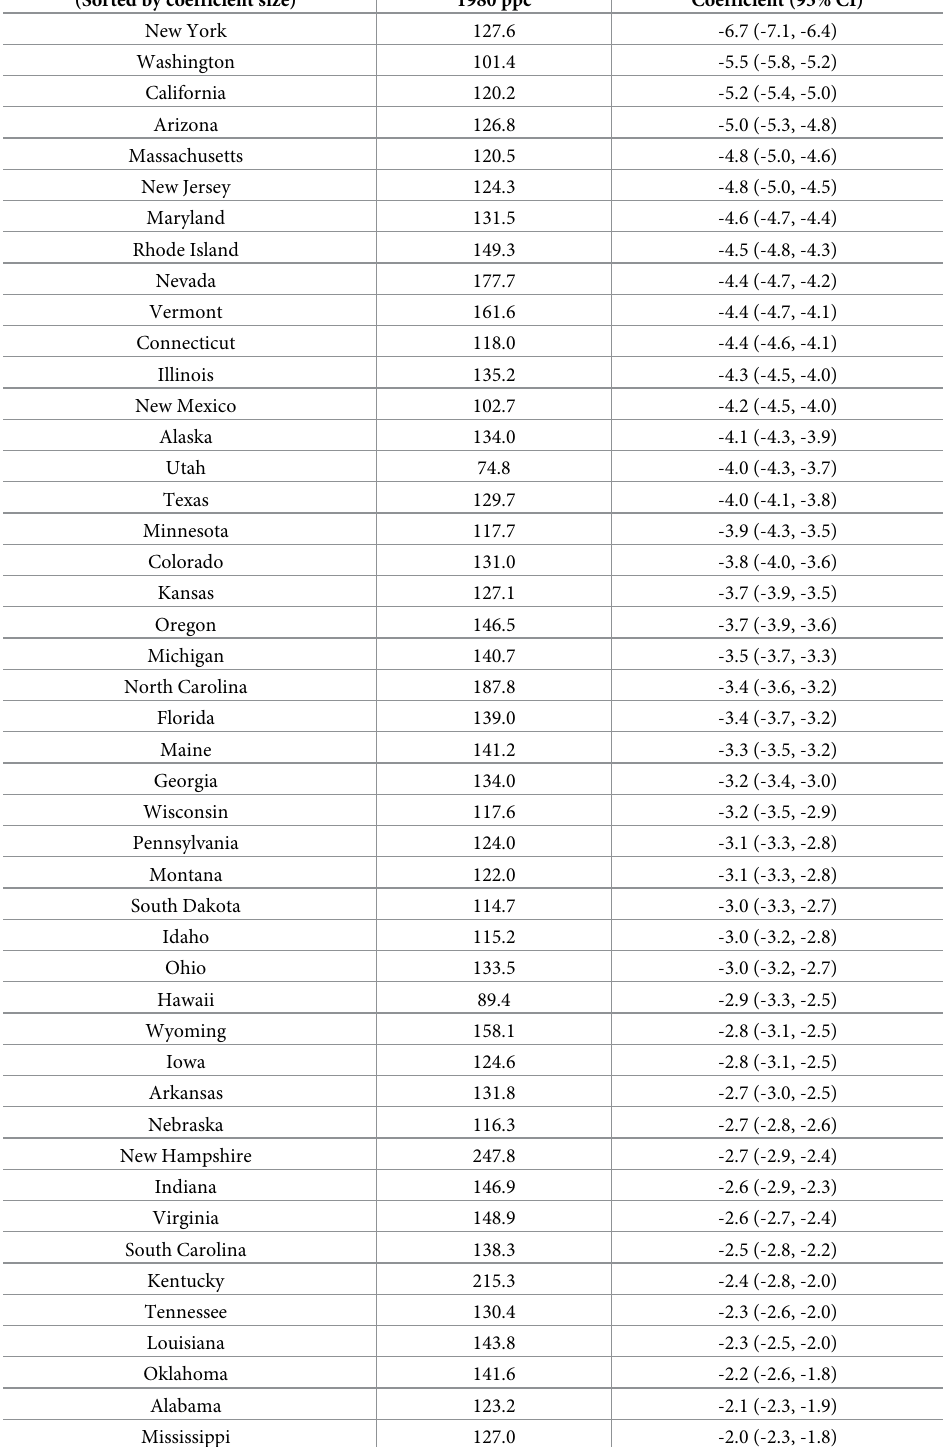
Table 1. Log-linear regressions summarizing the annual trends in cigarette consumption for US states from 1980 to